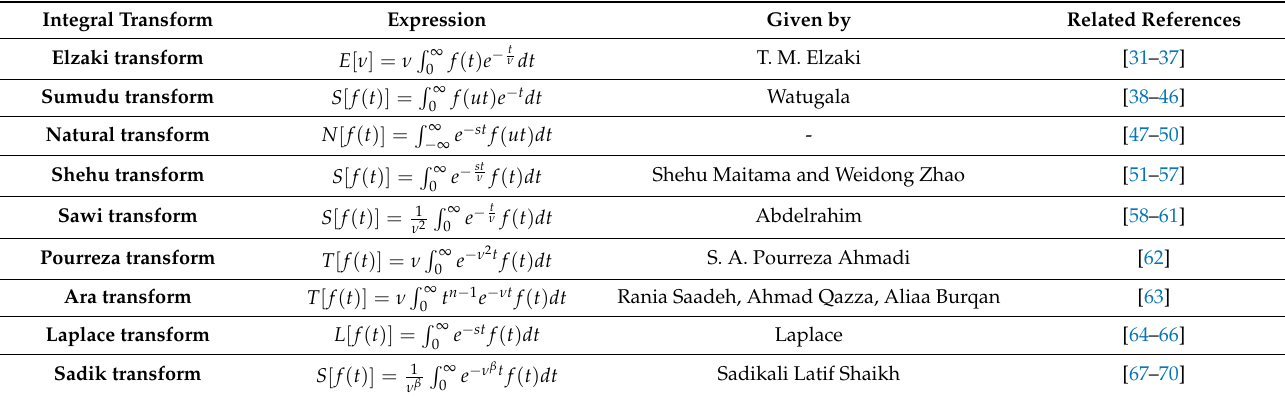
Table 1. Integral transforms.